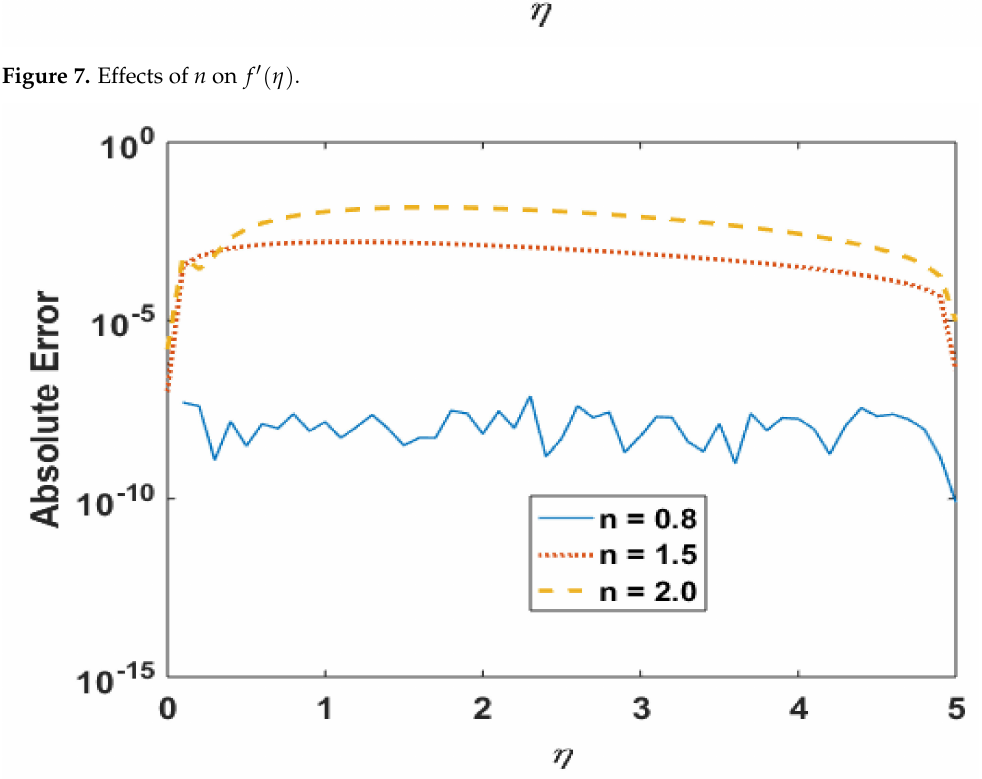
Figure 8. Absolute error in f (cid:48) ( η ) for different